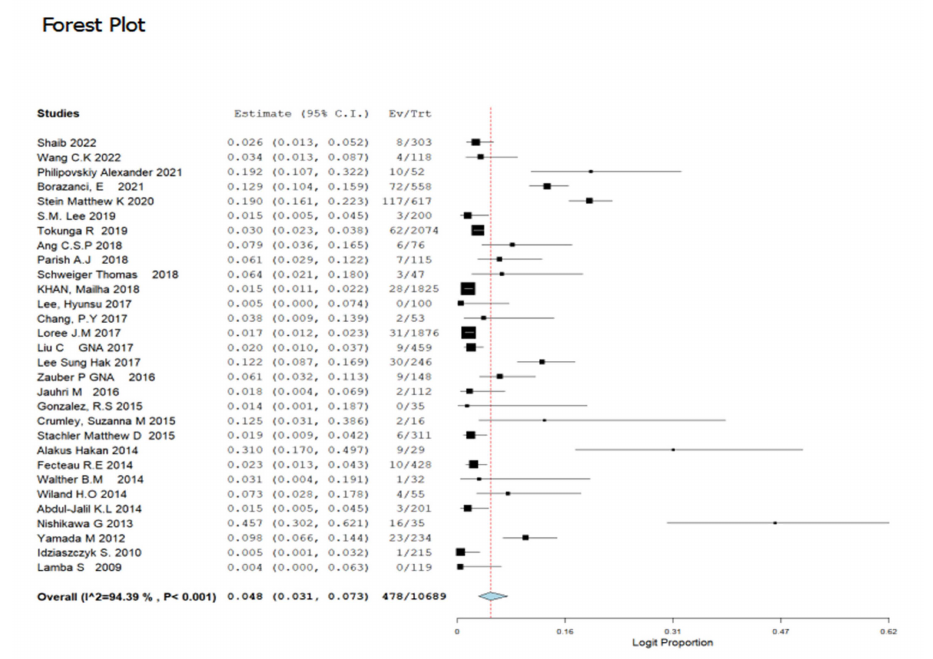
Figure 2. Forest plot for the prevalence of GNAS mutation in CRC patients [1,6,12,14,20–45].